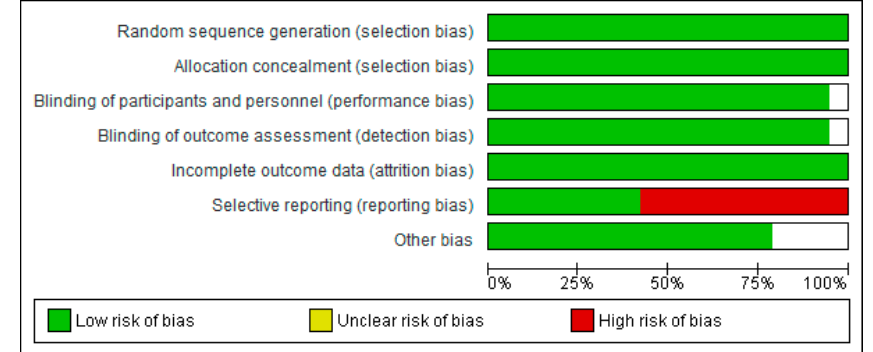
Figure 2. Risk of bias graph: review authors’ judgements about each risk of bias item presented as percentages across all included studies.